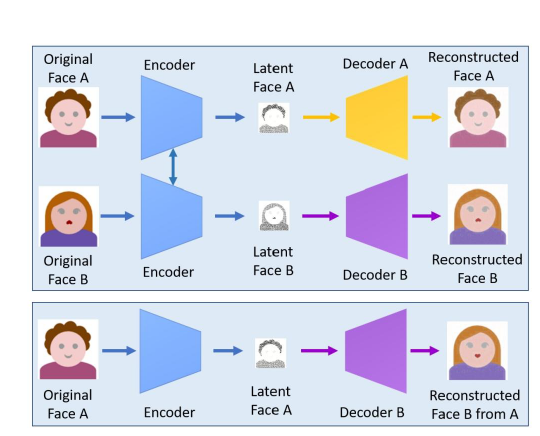
Figure 2. deepfaken creation model using two encoder-decoder pair